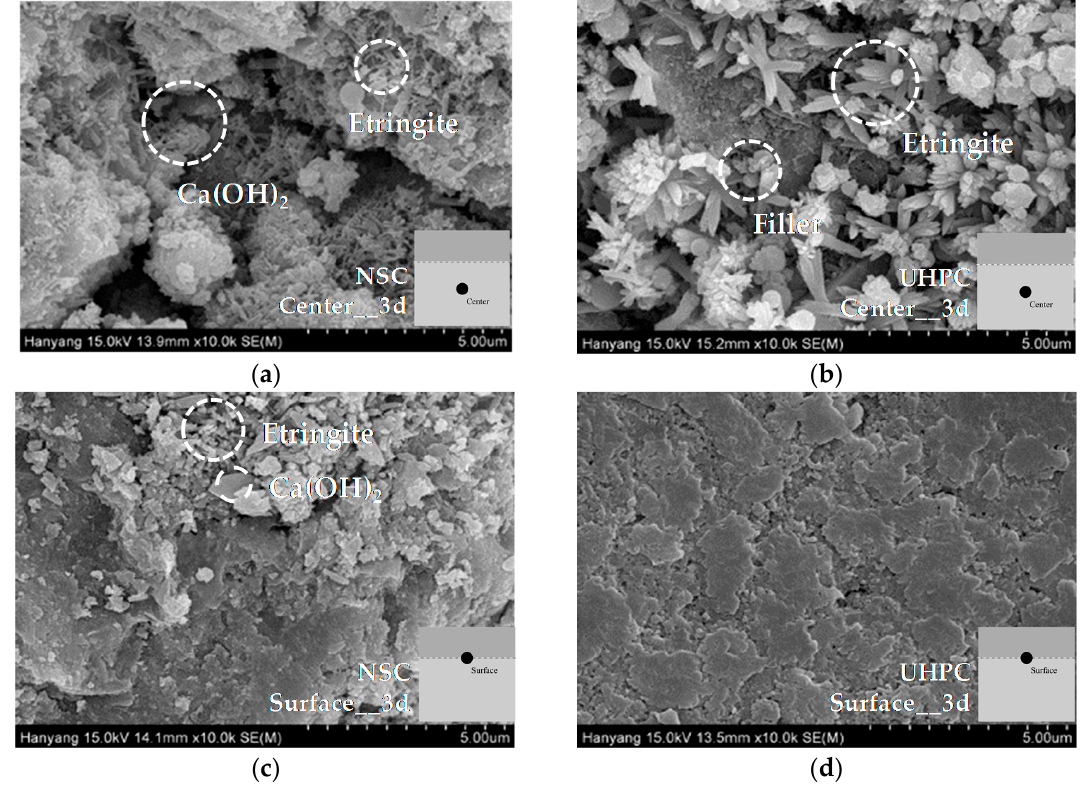
Figure 9. SEM analysis of middle sections and cold joint surfaces of NSC and UHPC (aged for three days): ( a ) middle section of NSC; ( b ) middle section of UHPC; ( c ) cold joint surface of NSC; and ( d ) cold joint surface of UHPC.